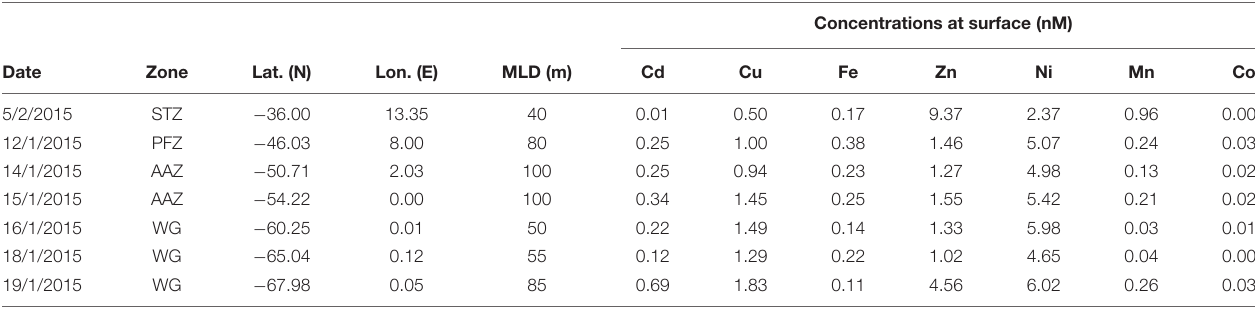
TABLE 1 | Surface trace metal concentrations (in nM) determined at seven stations across the Atlantic sector of the Southern Ocean measured during the third (January) and fourth (February) leg of voyage SANAE54 (see Figure 1 for cruise map).